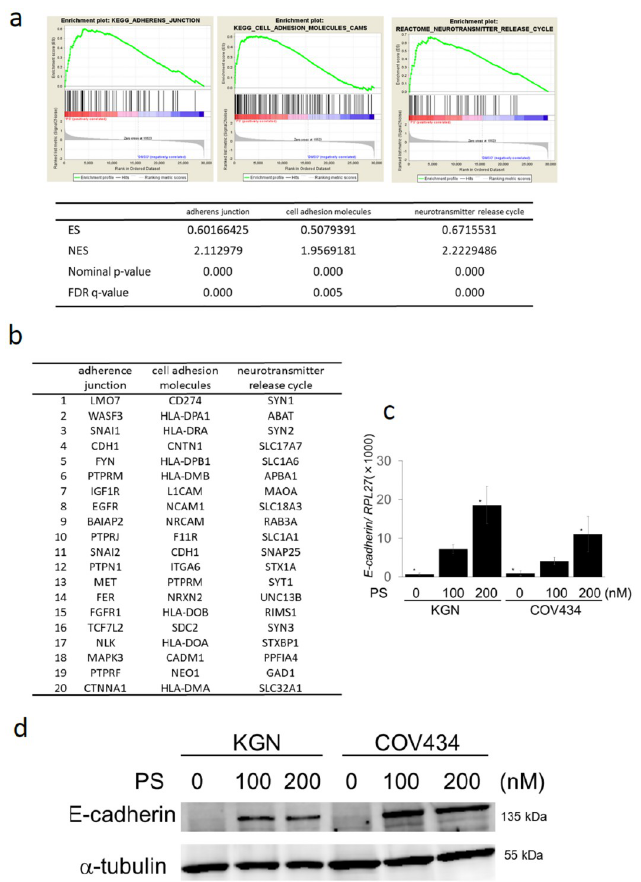
Fig 3. The gene enrichment analysis (GSEA) revealed the up-regulated gene sets: “Adherens junction”, “cell adhesion molecules”, and “neurotransmitter release cycle” in PS-treated KGN cells. a) PS (100 nM)-treated or untreated KGN cells were harvested at 24 hr. Gene expression profiling of KGN cells was examined in triplicate experiments and obtained data were used for GSEA by handling the GSEA software and the Molecular Signatures Database according to the references. The gene set “adherens junction”, “cell adhesion molecules” and “neurotransmitter release cycle” was strongly up-regulated by PS treatment and several statistical values are also presented. ES: enrichment score, NES: normalized enrichment score. b) The top 20 of most significant differentially expressed genes detected by GSEA analysis was shown. c) The expression of E-cadherin (official symbol: CDH1 ) in KGN and COV434 treated with 0–200 nM of PS for 24 h was examined by quantitative RT-PCR. The copy ratio of E- cadherin to RPL27 was calculated and indicated as a quantification of E-cadherin expression. d) The expression of E- cadherin in KGN and COV434 treated with 0–200 nM of PS for 24 h was examined by immunoblotting analysis.